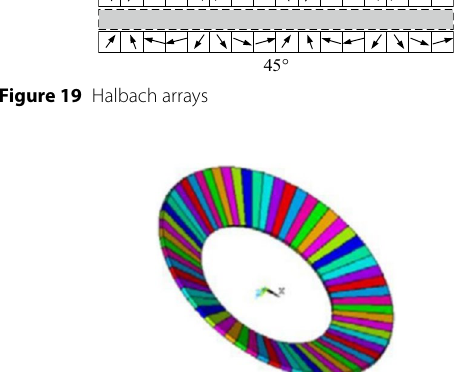
Figure 20 Structure of wedgy air-gap